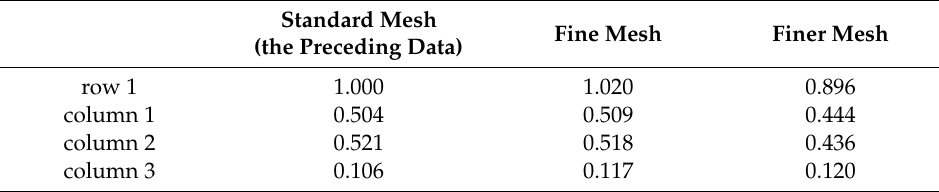
Table 2. Simulation results of the normalized value at varied mesh